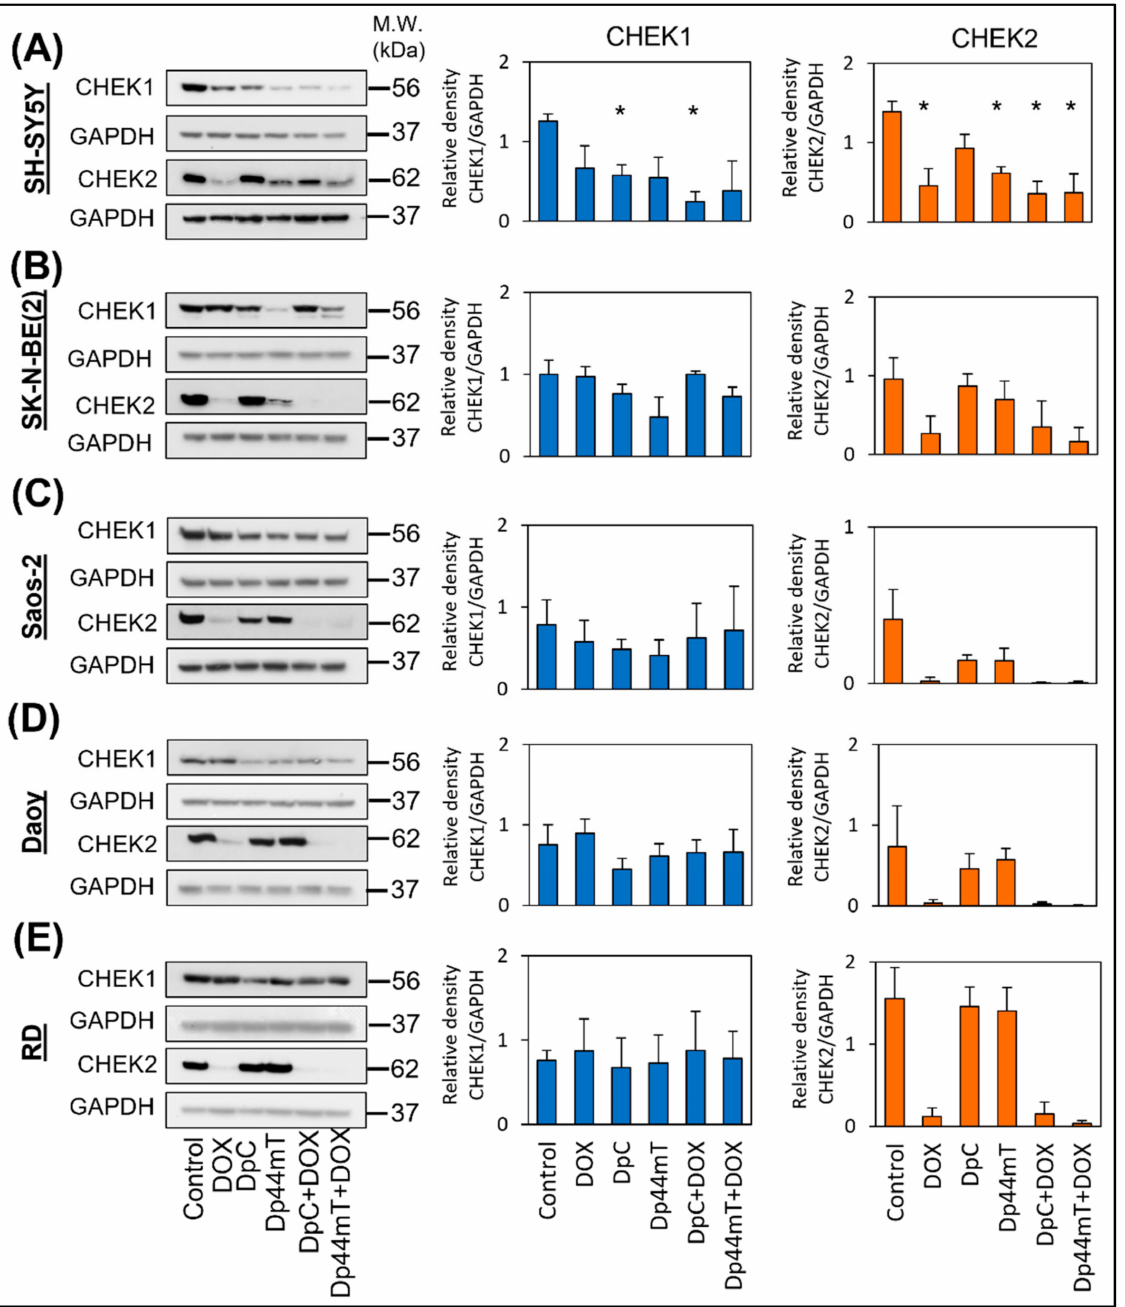
Figure 6. Immunoblotting to determine CHEK1 and CHEK2 levels in selected cell lines. CHEK1 and CHEK2 expression was evaluated in the SH-SY5Y ( A ), SK-N-BE(2) ( B ), Saos-2 ( C ), Daoy ( D ), and RD ( E ) cell lines after 3 days of incubation with IC 50 doses of DOX, DpC, Dp44mT, or their combinations. GAPDH served as the loading control. The experiments were performed in biological triplicates. The obtained data were analyzed by unpaired Welch’s t -test followed by Games–Howell post hoc test. * p < 0.05 indicates significant differences compared to the respective control